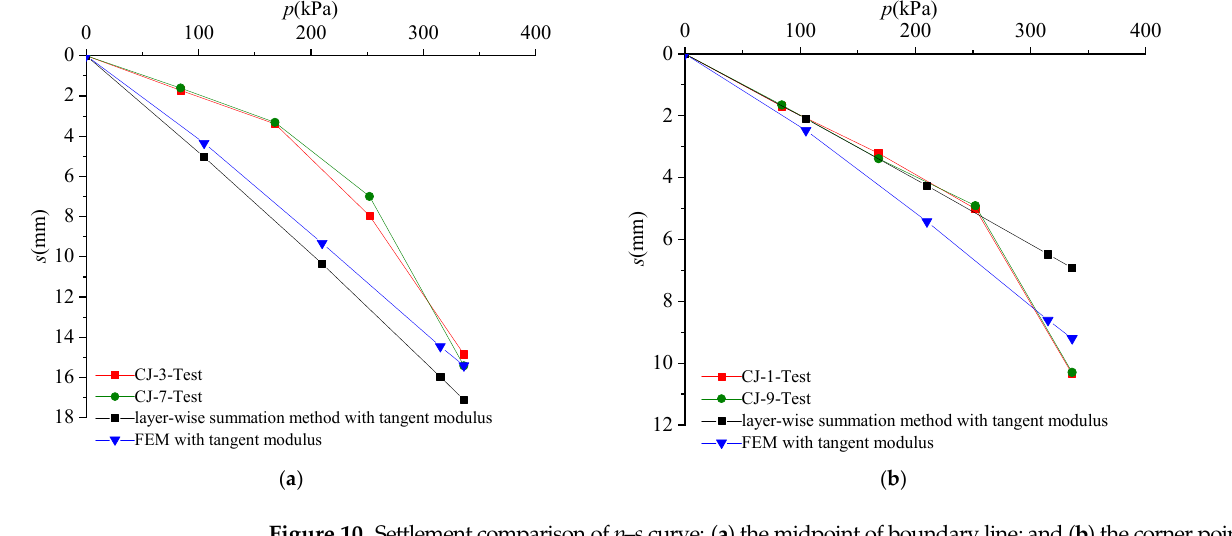
Figure 10. Settlement comparison of p – s curve: ( a ) the midpoint of boundary line; and ( b ) the corner point.